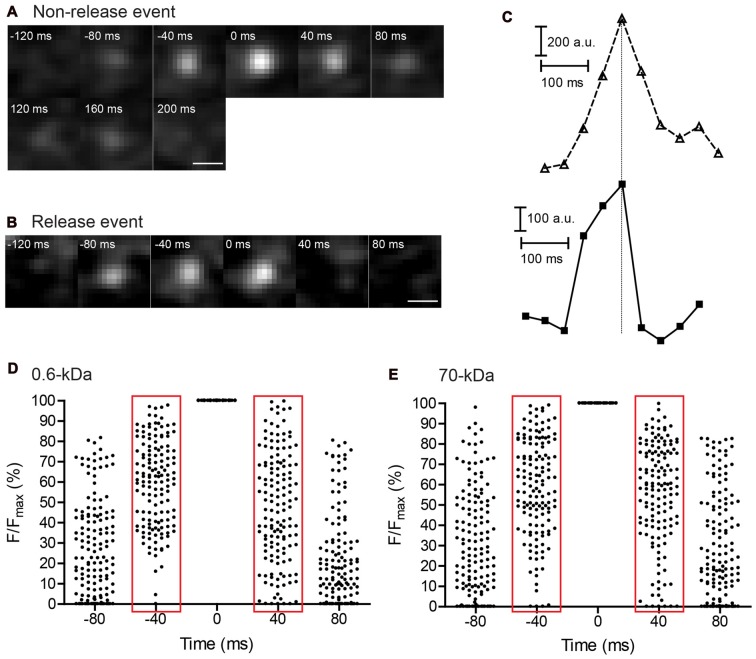
Imaging of individual vesicle release events using TIRFM in rods. Consecutive 40-ms images showing a non-release event (A) and release event (B) in individual synaptic vesicles loaded with SR101. Scale bars: 0.5 μm. (C) Fluorescence changes were measured within a 7 × 7 pixel region of interest enclosing the vesicles in (A; top) and (B; bottom) and plotted as a function of time. Vertical line aligns the peak fluorescence values. Vesicle fluorescence declined more rapidly during release than during non-release events in which fluorescence declined at a rate similar to the rate of increase observed as a vesicle approached the membrane. (D,E) Scatter plots of normalized fluorescence values measured in individual vesicles during the final two 40-ms frames of vesicle approach to the membrane and the first two frames during fluorescence decline. Data show vesicles loaded with SR101 (N = 143 events) (D) and 70-kDa Texas Red (N = 142) (E) during 50 mM K+ puff.